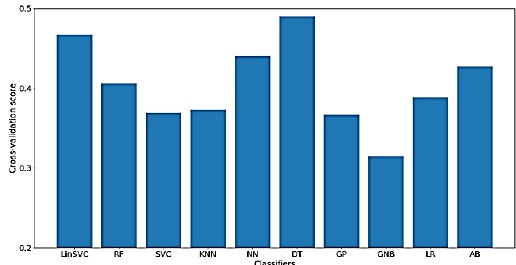
Figure 17. Performance of selected classifiers for the classification of WM scores using NoOutlier data and only time-domain features.